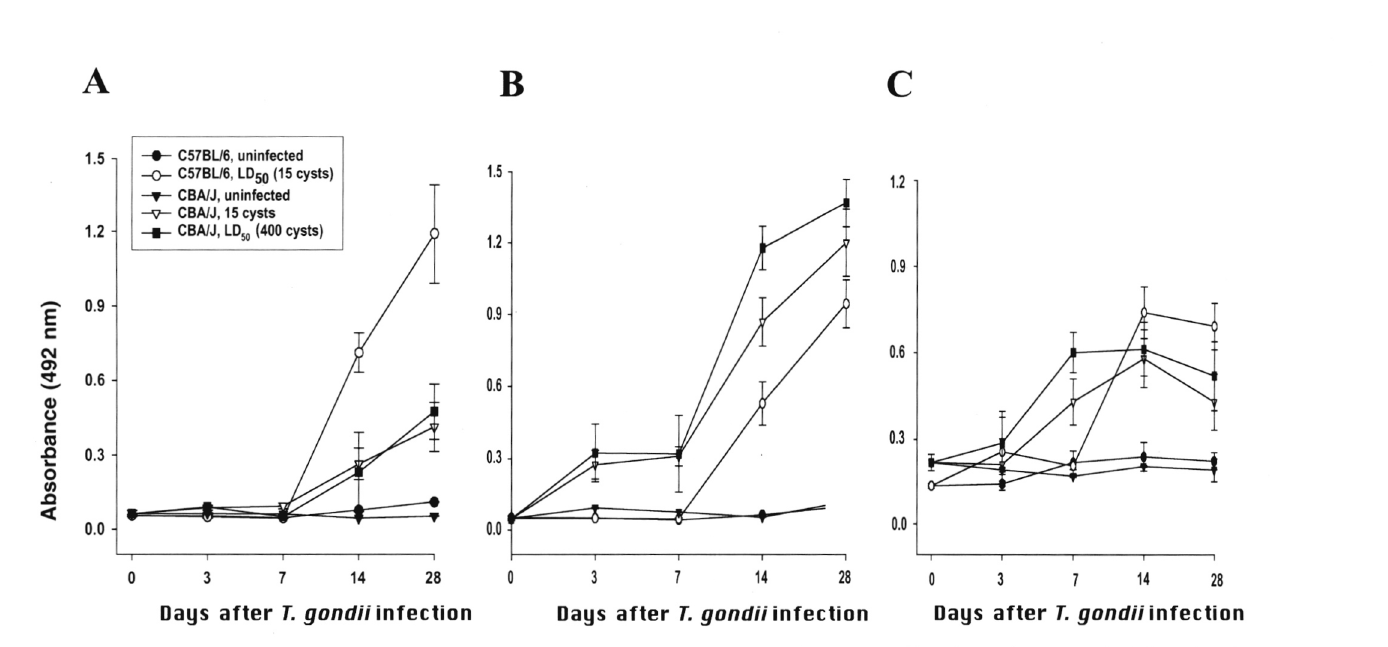
Fig. 2. - Time course of the IgG1 (A), IgG2a (B), and IgM (C) antibody titers of sera from C57BL/6 and CBA/J mice orally infected with the 76K strain of T. gondii. The data are expressed as mean ± SD of one of two separate experiments (n = 5 for each value at all time point). The experiment was repeated two times with essentially similar results.